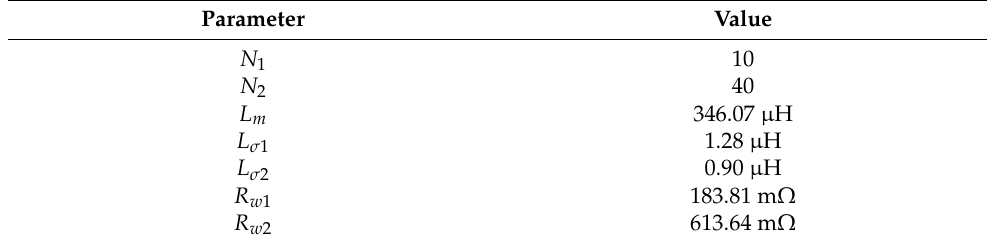
Table 6. Parameters of the